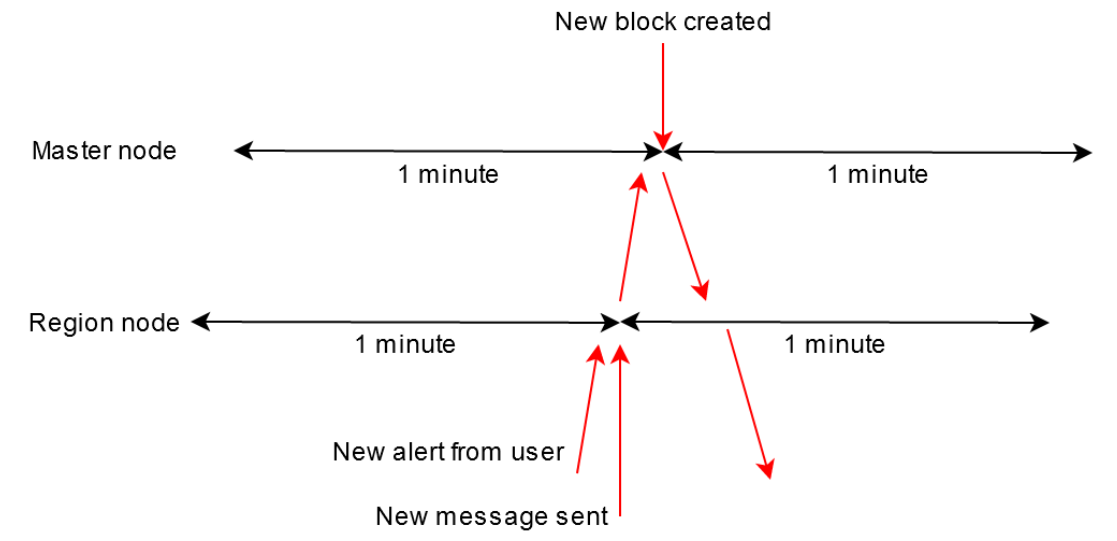
Figure 15. Propagation time - best-case